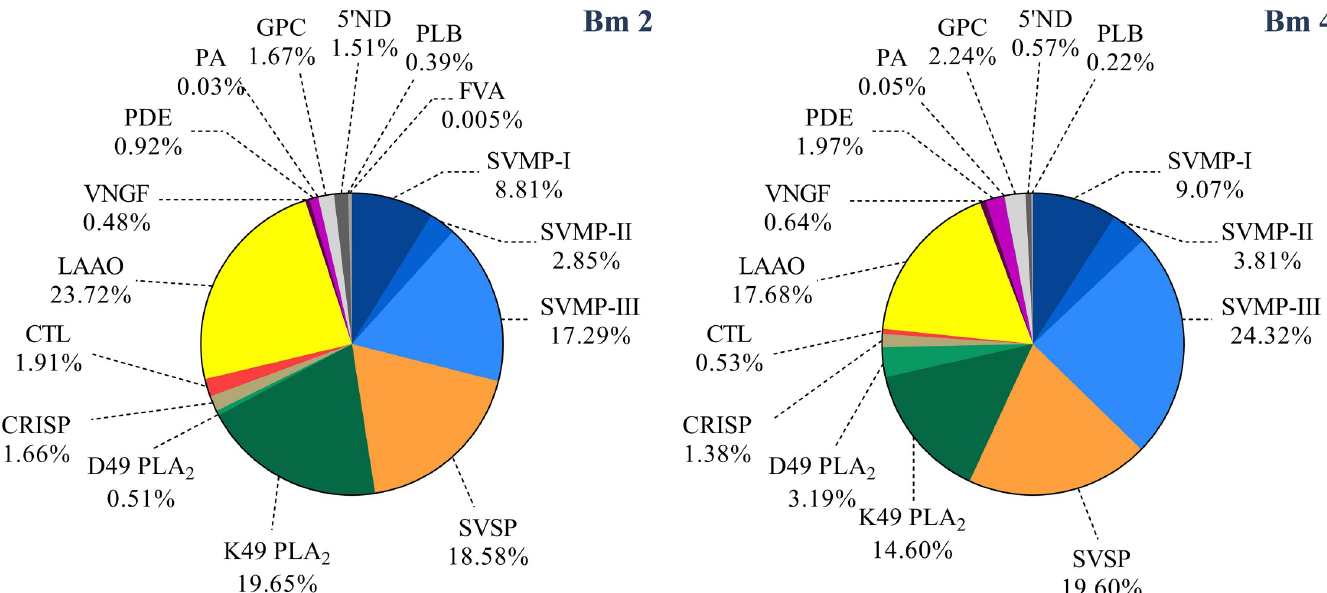
Fig 7. Overall composition of B . moojeni snake venom. Individuals Bm2 and Bm4, according to protein families, expressed as percentages. (PI-, PII- and PIII-SVMP) snake venom metalloproteinase of PI, PII and PIII class, respectively; (SVSP) snake venom serine protease; (D49/K49 PLA 2 ) phospholipase A 2 D49 and 49, respectively; (CRISP) Cysteine-rich secretory protein; (5’ND) 5’Nucleotidase; (PLB) phospholipase B; (GPC) Glutaminyl-peptide cyclotransferase; (CTL) C-type lectin; (PDE) phosphodiesterase; (LAAO) L-amino acid oxidase; (VNGF) venom nerve growth factor; (PrAct) prothrombin activator; (PlasmAct) plasminogen activator.